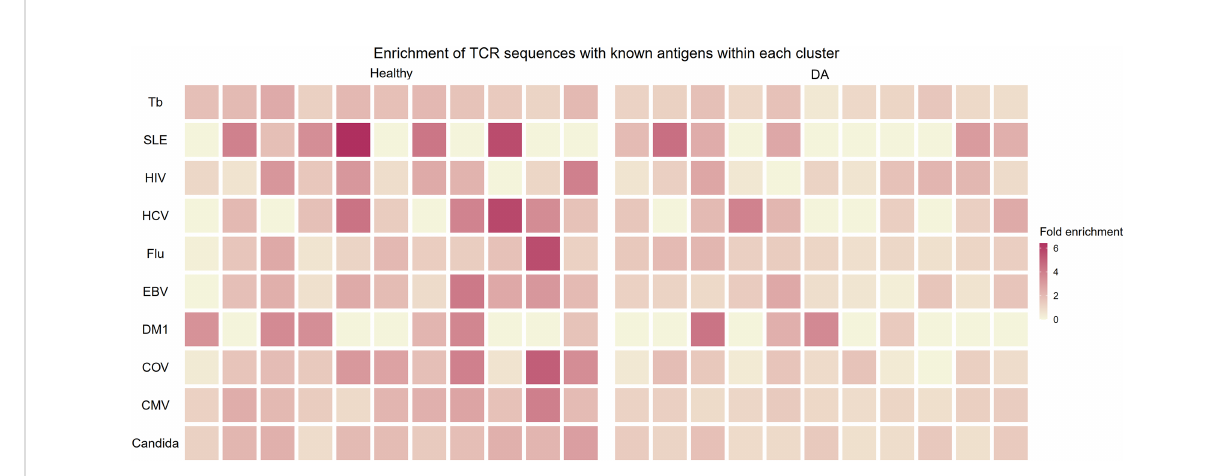
FIGURE 8 Heatmap showing enrichment of TCR sequences with known antigens within T cell clonotype clusters from proportional correlation-based clustering. DA, disease-associated CMV cytomegalovirus COV SARS-CoV-2 EBV Epstein-Barr virus Flu In fl uenza virus HCV hepatitis C virus HIV human immunode fi ciency virus MTb Mycobacterium tuberculosis SLE systemic lupus erythematosus T1DM diabetes mellitus type